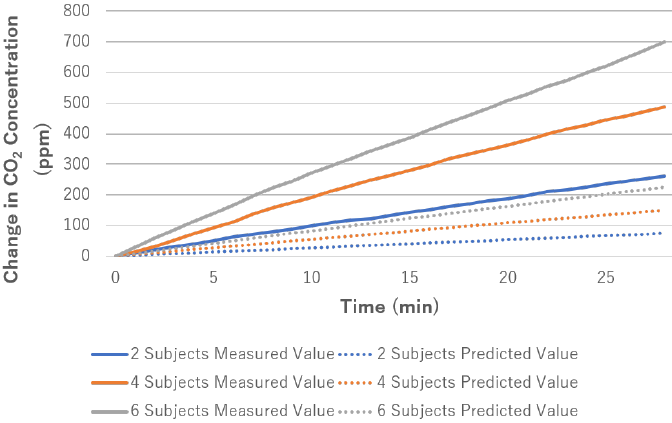
Figure 14. Predicted and measured values of CO 2 concentration in the medium studio (2, 4, 6 subjects).